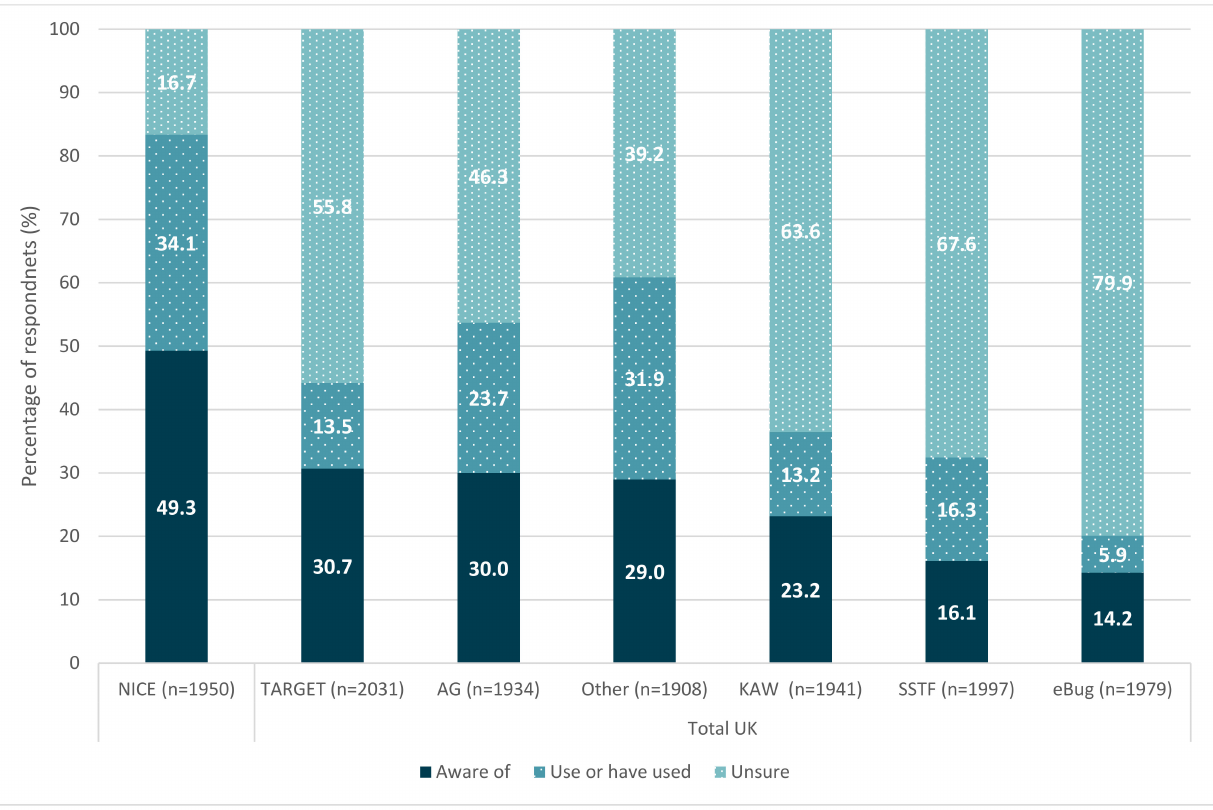
Figure 4. Awareness of campaigns, projects and platforms related to antibiotic use and AMR in the